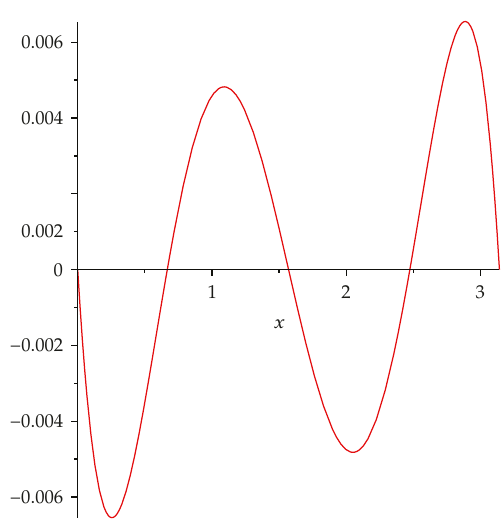
between cos x and p 3 (cid:2) x (cid:6) on (cid:4) 0 ,π (cid:3) 3 (cid:2) x (cid:6)